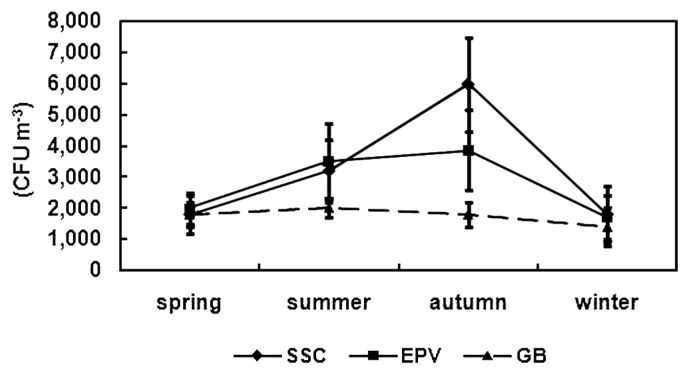
Seasonal variation patterns of the airborne concentration of total culturable bacteria.